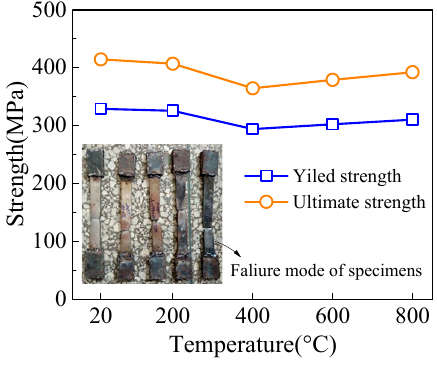
Figure 8. Measured steel properties. Table 6. Steel properties exposed to ETWC.